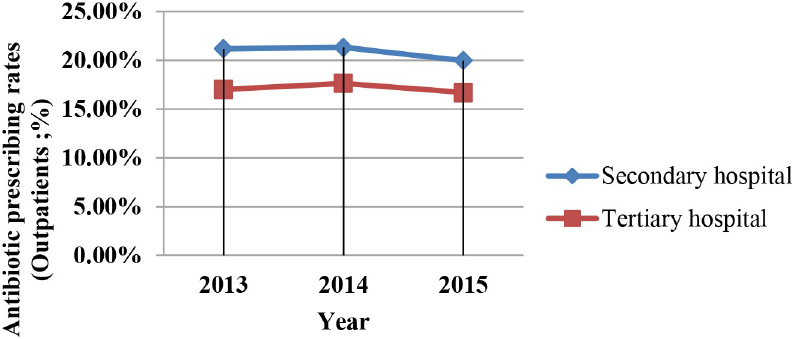
Fig 1. Antibiotic prescription rates of outpatients in tertiary and secondary hospitals. Antibiotic prescription rates of outpatients in Different Levels of Hospitals by Year.